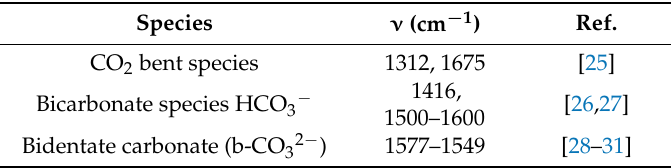
Figure 2. Diffuse reflectance infrared Fourier transform spectroscopy (DRIFTS) spectra of CO 2 interaction with gold supported photocatalysts. Table 1. IR main bands assignment for Au/TiO 2 Samples.